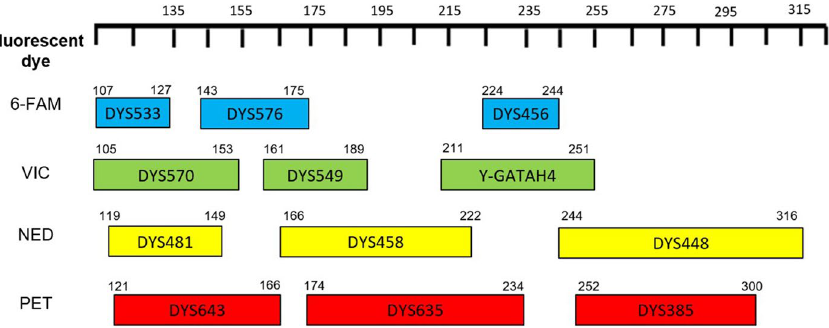
Figure 1. Design of the 11 plus DYS385a/b Y-STR multiplex panel developed in the present study. The boxes represent the expected fragment sizes for each locus and the color of the fluorescent dye with which forward primers were labeled. The scale at the top represents the size (bp) and the fluorescent dye for the corresponding loci is shown on the